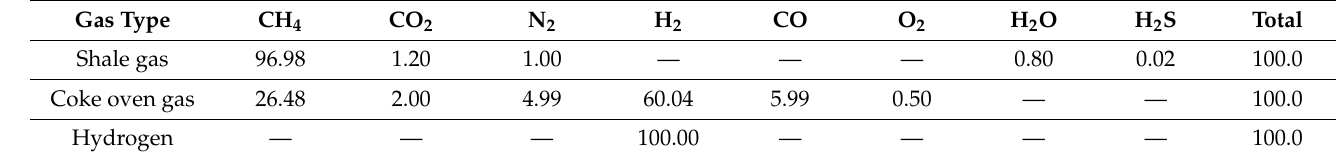
Table A6. Hydrogen–rich gas composition for calculation (vol.%).